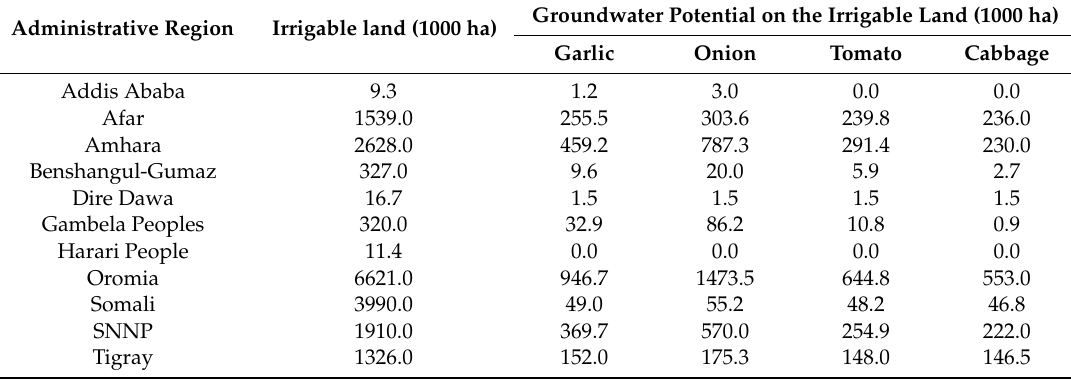
Table 3. Irrigable land and potential of groundwater for various vegetables. Groundwater Potential on the Irrigable Land (1000 ha) Administrative Region Irrigable land (1000 ha) Garlic Onion Tomato